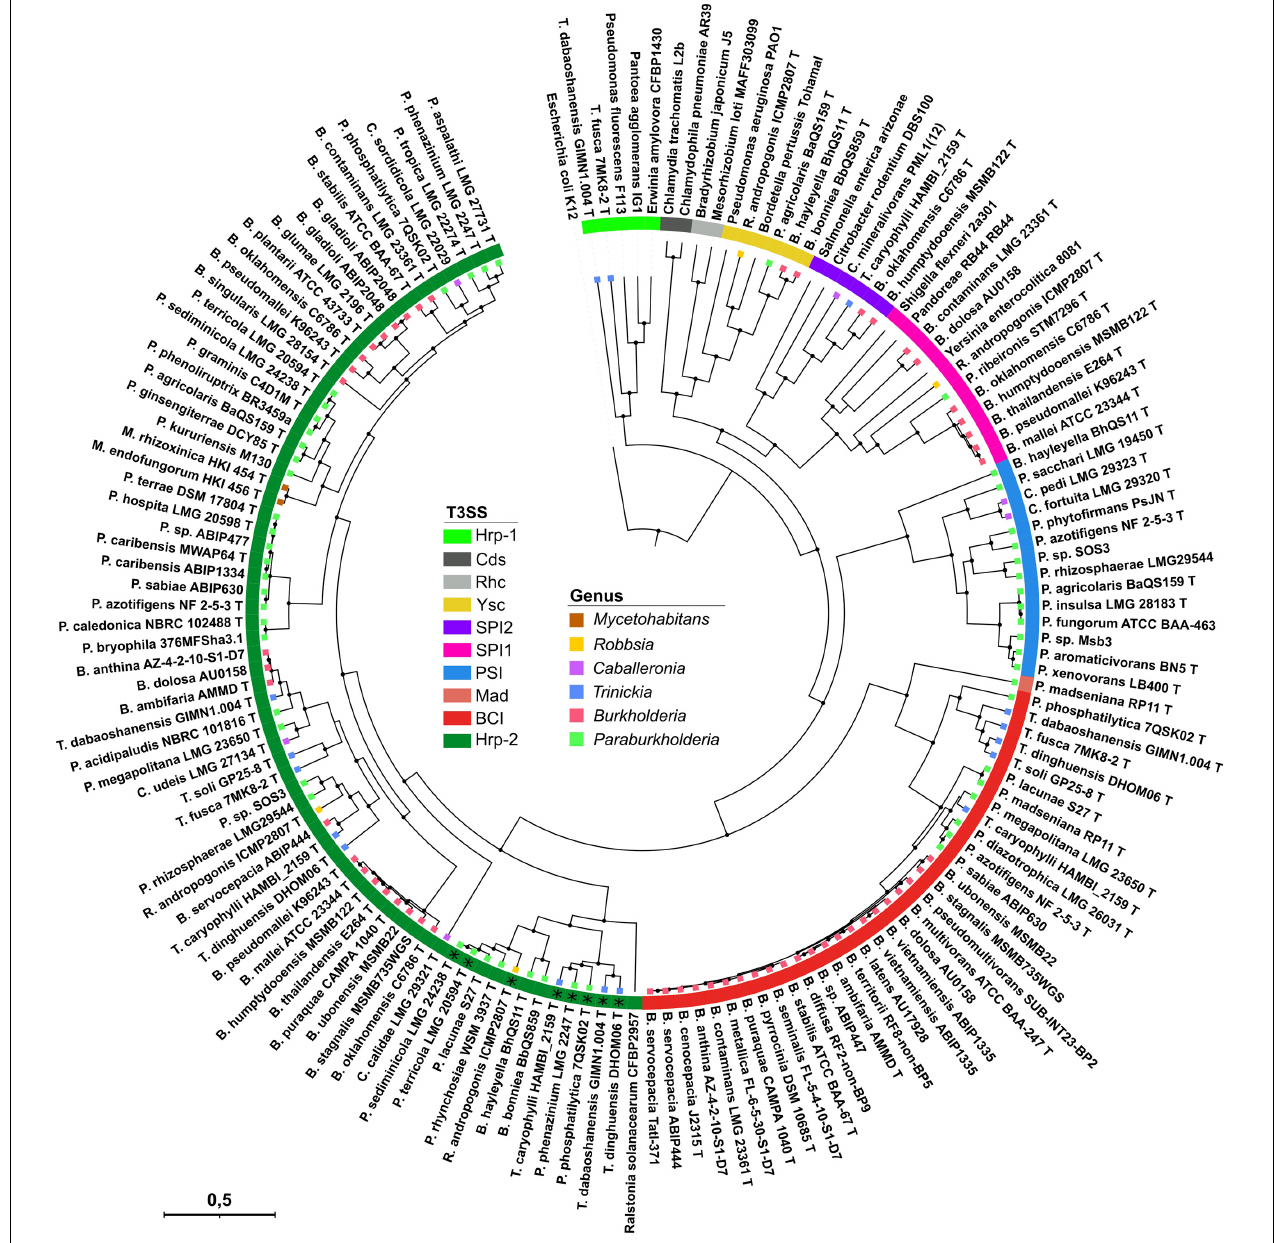
FIGURE 1 | Phylogenetic reconstruction of T3SS cluster evolution amongst Burkholderia s.l . species. 80 Burkholderia s.l. strains containing a total of 136 secretion systems are represented. Their phylogenetic distribution was inferred using a Bayesian prediction on the concatenated SctC, SctN, SctT, SctV protein sequences resulting in a 1,652 aa alignment. Homologous flagellum components were used for the outgrouping E. coli strain in order to root the tree. The colored strip indicates the T3SS types and the colored squares at the branch tips represent the genus of each strain. (*) Eight strains possess a second Hrp-2 injectisome which is phylogenetically close to the one from Ralstonia